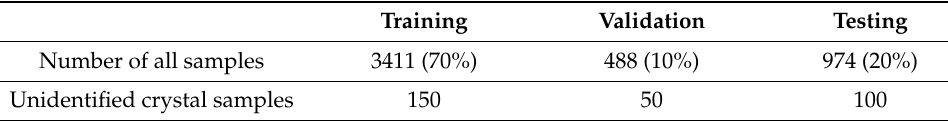
Table 3. Input EP dataset statistics.